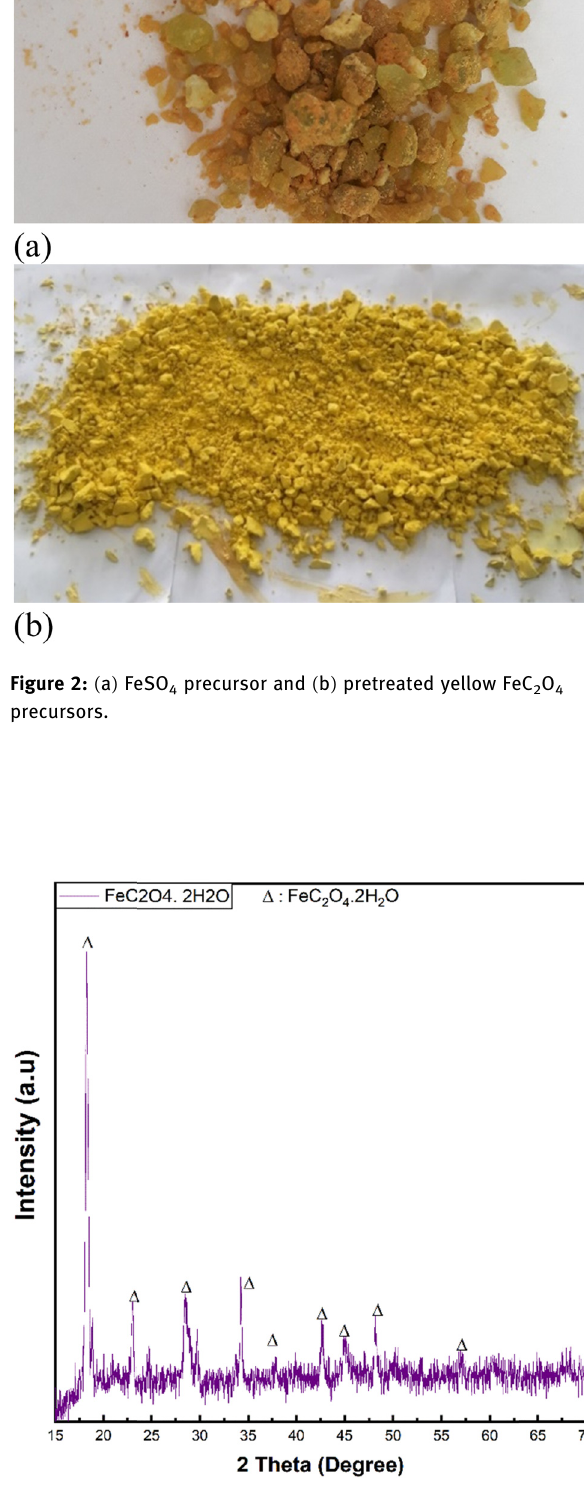
Figure 3: XRD pattern of FeC 2 O 4